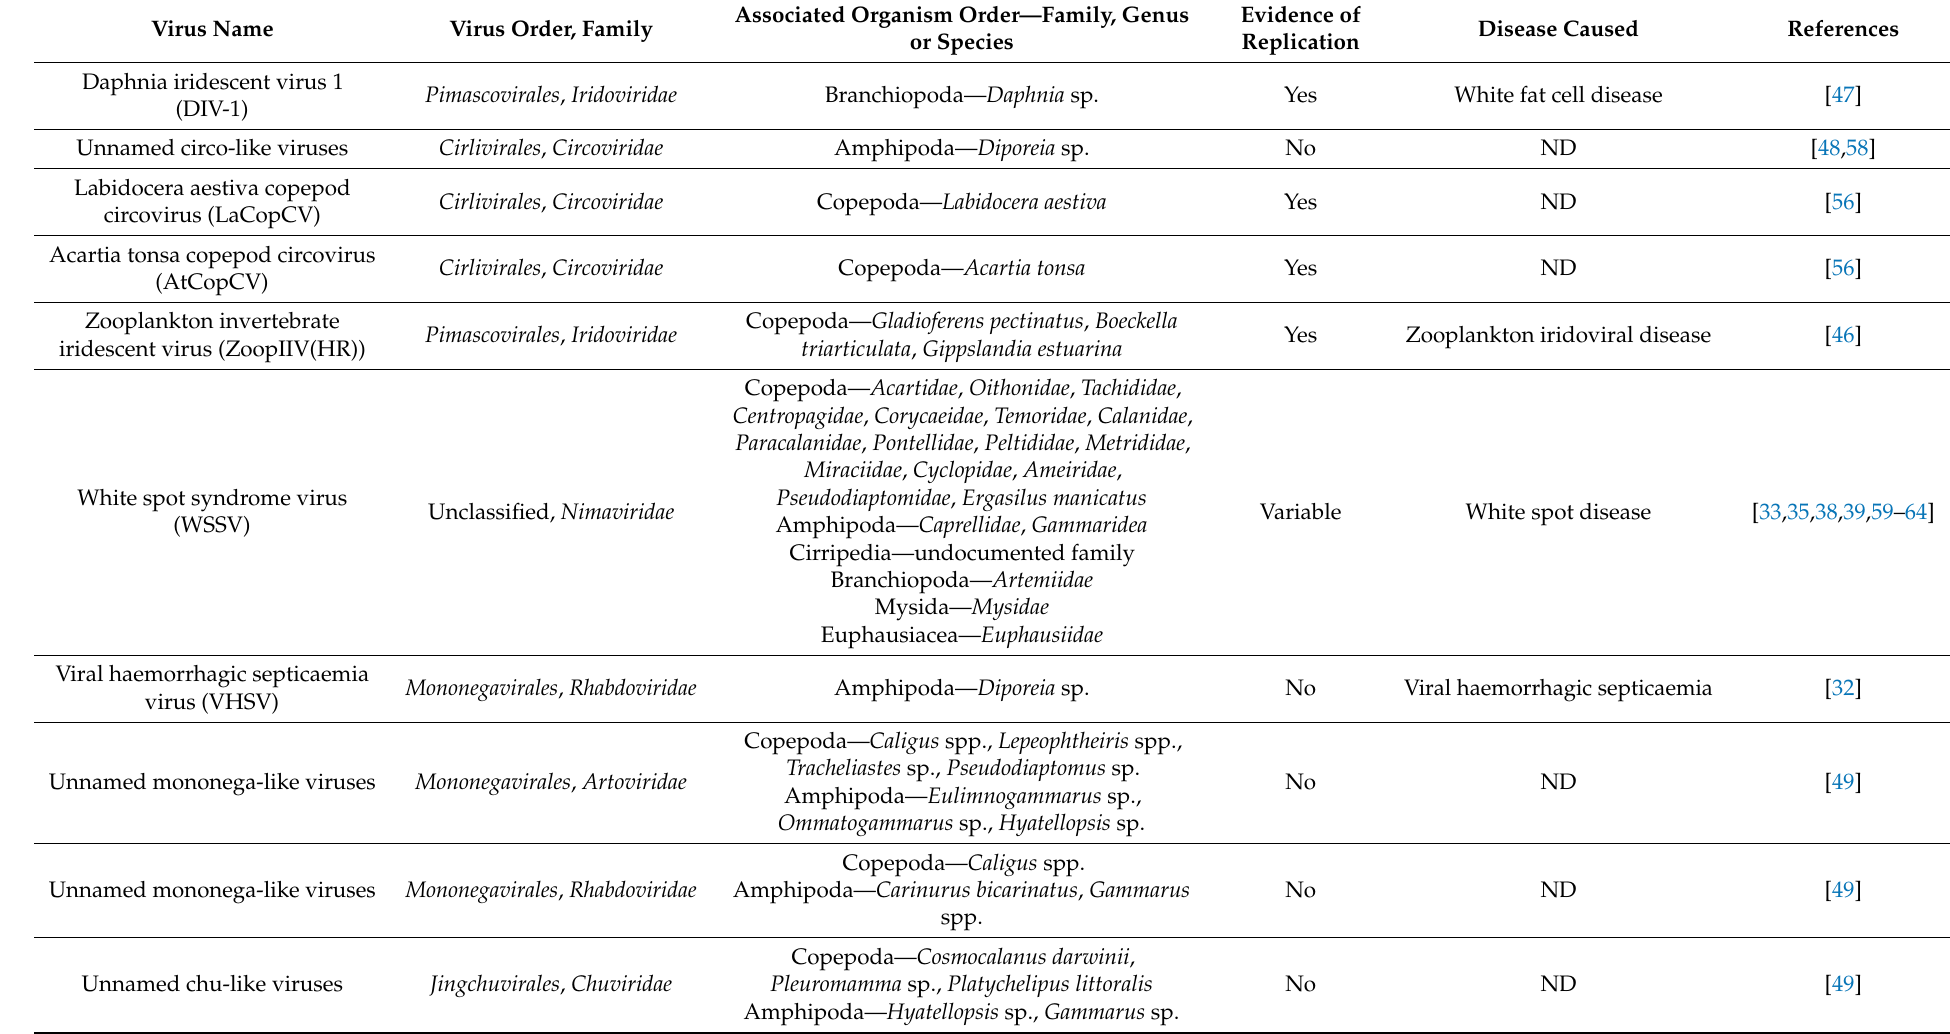
Table 1. Viruses associated with or infecting crustacean